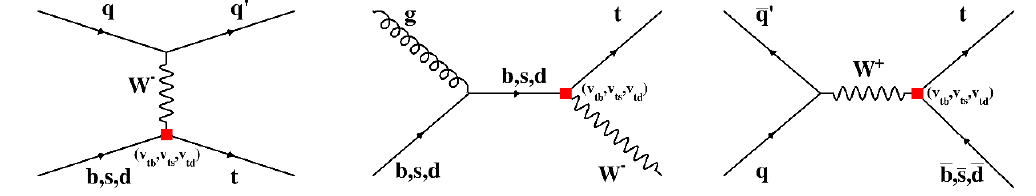
Figure 1 . Feynman diagrams for single top quark production in t -channel (left), tW (middle) and s -channel (right) modes in the presence of non-zero j V tb j , j V ts j and j V td j